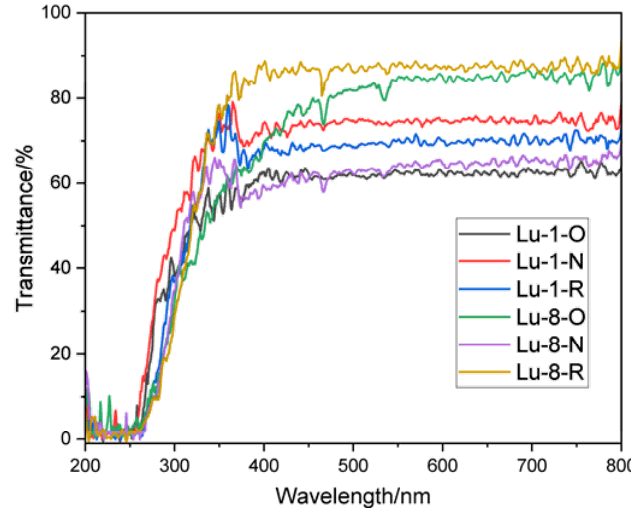
Figure 2. Optical transmittance spectra of Lu 2 O 3 :1%Eu and Lu 2 O 3 :8%Eu single crystals.